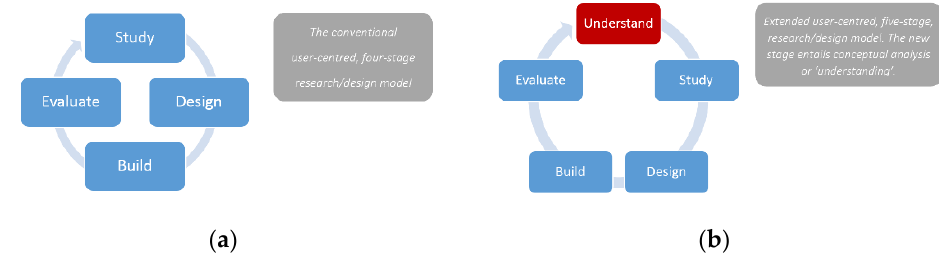
Figure 2. ( a ) Conventional user-centered model; and ( b ) extended user-centered model following [28] .